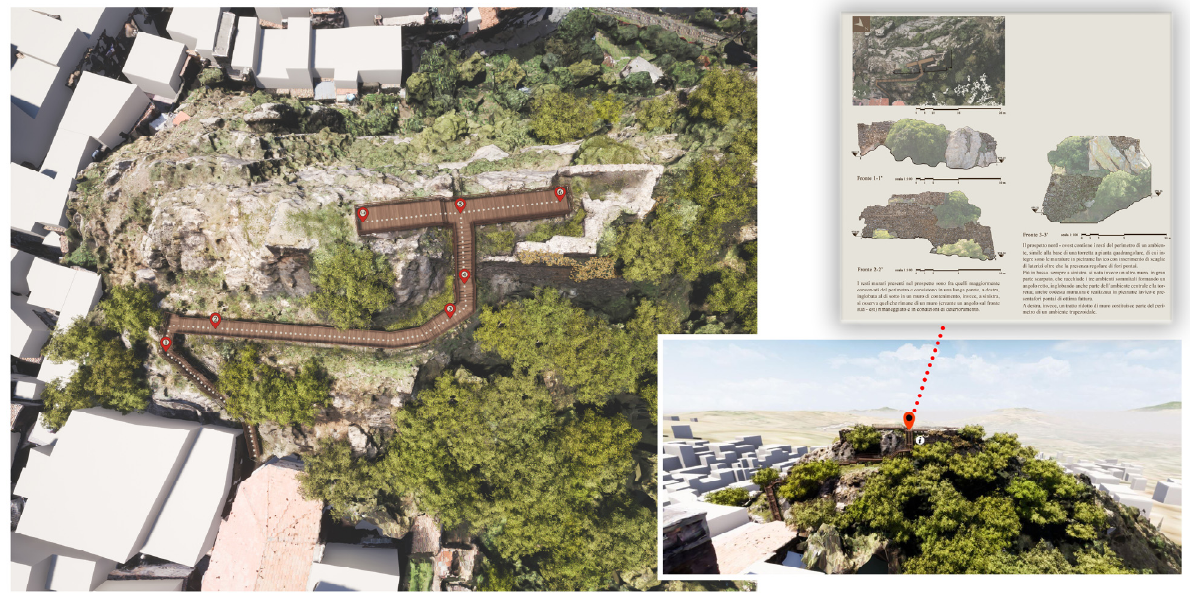
Figure 4. Maletto Castle. Smart navigation and interactive query of the 3D